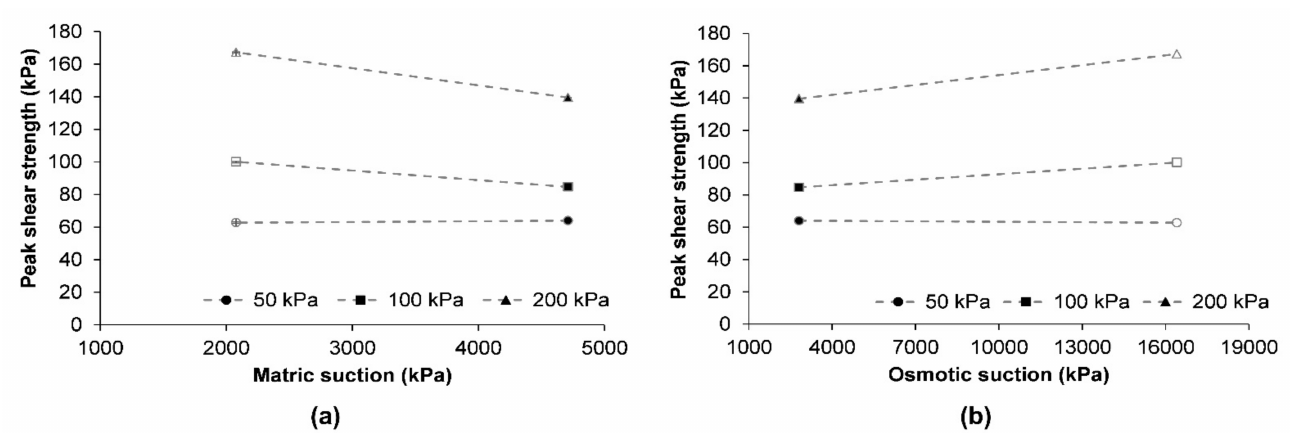
Figure 4. Influence of diesel contamination: ( a ) matric suction and ( b ) osmotic suction in the shear strength of soil. The symbols filled in black color correspond to natural soil while the symbols in grey color correspond to contaminated soil.